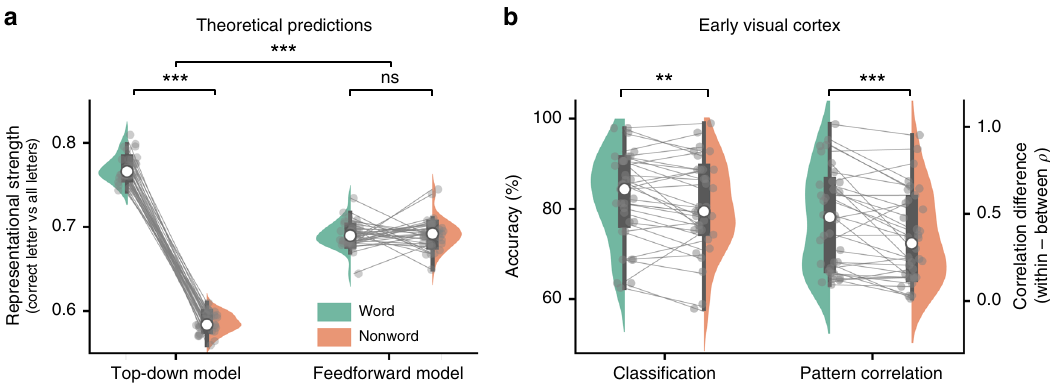
Fig. 3 Word contexts enhance letter representations. a Theoretical predictions. We simulated 34 arti fi cial ‘ runs ’ in which we exposed a network with (top – down model) and without (feedforward model) word-to-letter feedback connections to the experimental stimuli, and computed the average representational strength of the middle letter in word and nonword contexts. Note that the strong dissociation was observed despite the fact that the middle letter was well-above threshold in all conditions for both models (Supplementary Fig. 2). b Letter representation in early visual cortex of 34 human observers. Two multivariate pattern analysis methods (see Methods) revealed that neural representations of letters were enhanced in word compared to nonword contexts, supporting the top – down model. In both panels, grey dots represent individual simulated ‘ runs ’ ( a ) or individual participants ( b ). Lines represent paired differences. White dots, boxes and whiskers represent between-subject medians, quartiles and 1.5 interquartile ranges, respectively. Signi fi cance levels correspond to p < 0.01 (**) or p < 0.001 (***) in a paired, two-tailed Student ’ s t or Wilcoxon sign rank